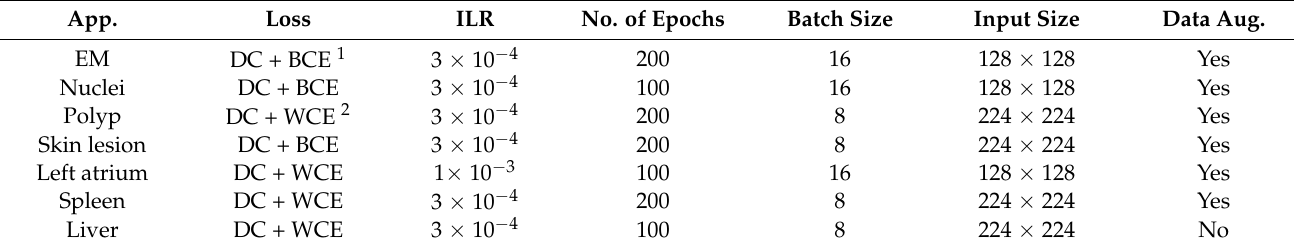
Table 3. The details of learning setting of the